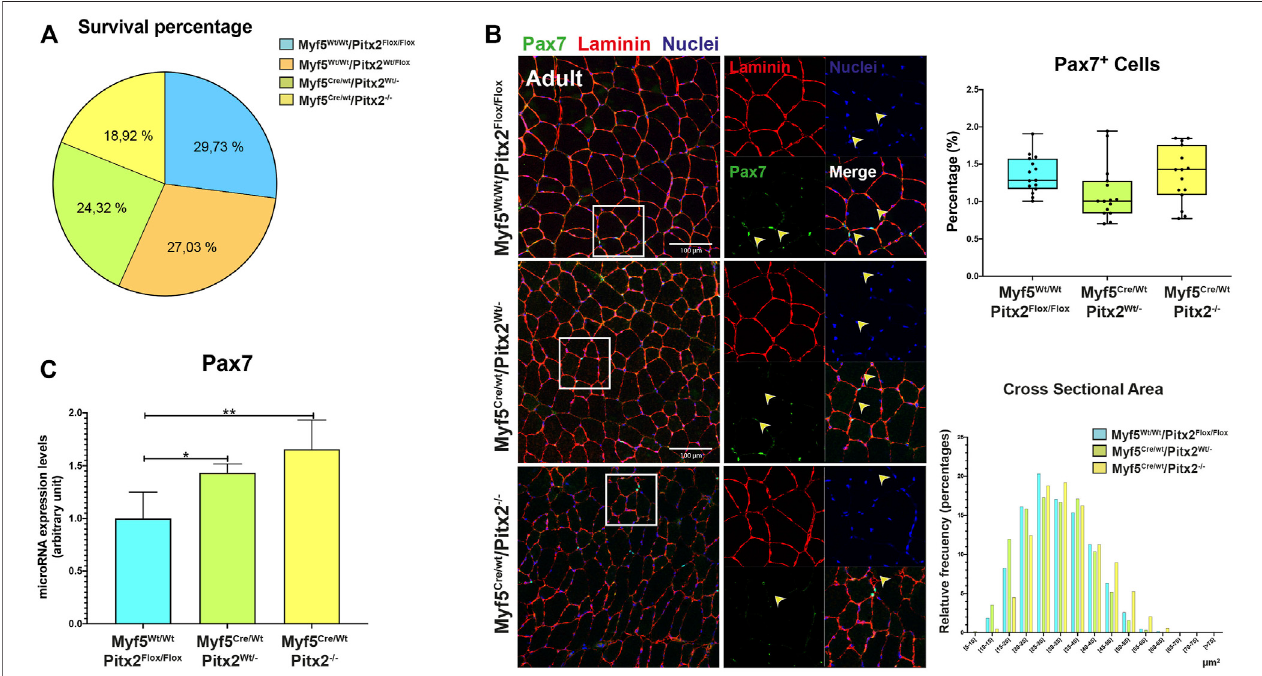
FIGURE 8 | Myf5 Cre/Wt /Pitx2 − / − mice have normal survival rates but possess satellite cells with high Pax7 expression. (A) Survival rates for Myf5 Wt/Wt /Pitx2 Flox/Flox , Myf5 Wt/Wt /Pitx2 Flox/Wt , Myf5 Cre/Wt /Pitx2 Wt/- and Myf5 Cre/Wt /Pitx2 − / − mice. (B) Representative images of PAX7 and LAMININ co-immunostaining in the TA muscles of Myf5 Wt/Wt /Pitx2 Flox/Flox , Myf5 Cre/Wt /Pitx2 Wt/- and Myf5 Cre/Wt /Pitx2 − / − mice and quanti fi cation of PAX7 + cells. (C) qRT-PCR analyses for Pax7 in the TA muscles of Myf5 Wt/Wt Pitx2 Flox/Flox , Myf5 Cre/Wt /Pitx2 Wt/- and Myf5 Cre/Wt /Pitx2 − / − mice. * p < 0.1, ** p < 0.01 ( n = at least 3 mice per